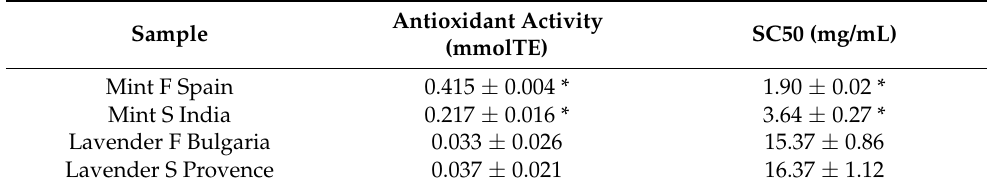
Table 3. Antioxidant activity of Mentha piperita and Lavandula angustifolia measured by TEAC method.